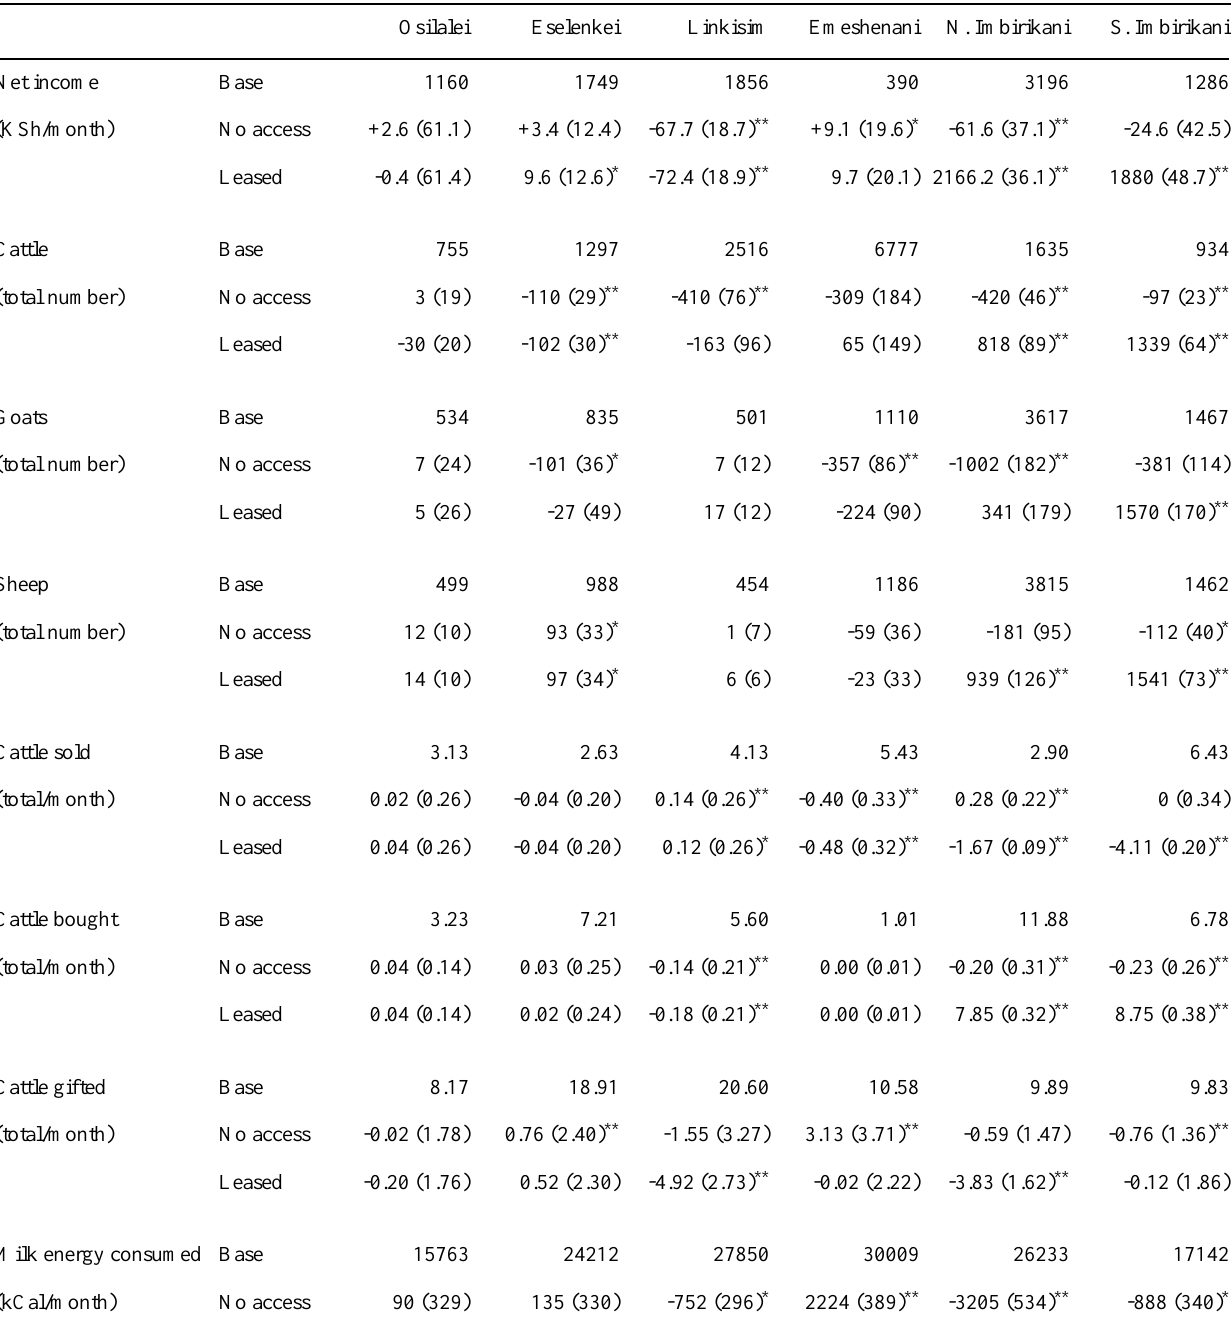
Table 2 . Metrics that represent average (and standard error) responses across the six study areas for simulated households corresponding to the 184 for which survey data were available. Values given are: the base simulation (Base), when access to the Chyulu Hills was lost without compensation (No access), and when access was lost but households in ranches neighboring the Chyulu Hills were compensated